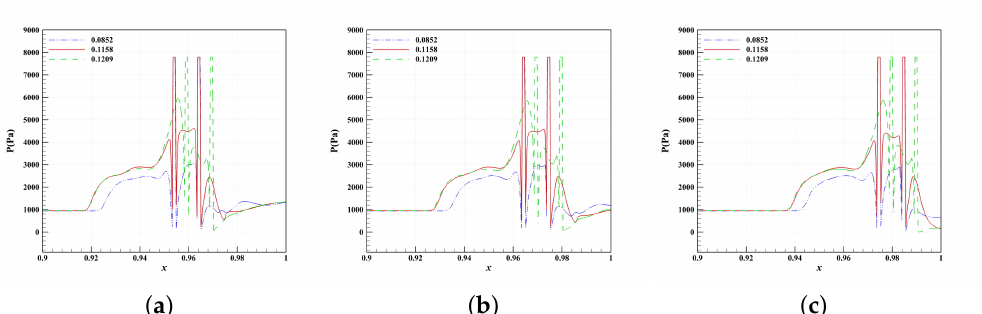
Figure 17. Surface Pressure Distribution on Selected Section Planes (Section Plane z = 0.0852 (Blue, Dashed Dot Dot), 0.1158 (Red, Solid) and 0.1209 (Green, Dashed)). ( a ) Case 6 ( C M = 0.002430), ( b ) Case